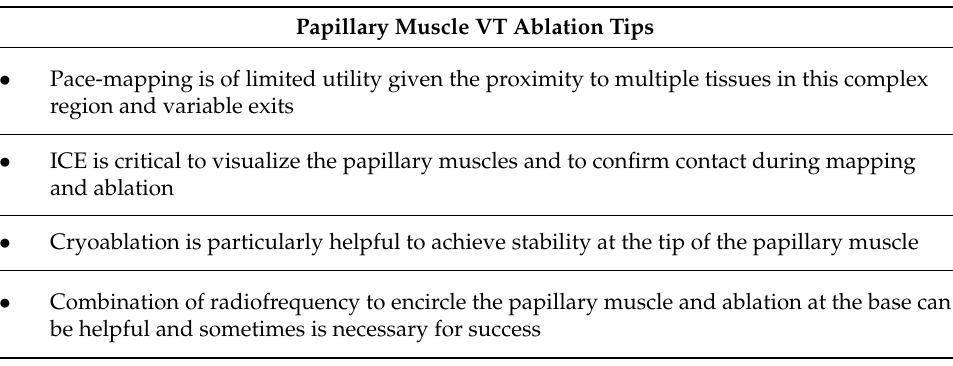
Table 4. Summary of papillary muscle ablation tips.